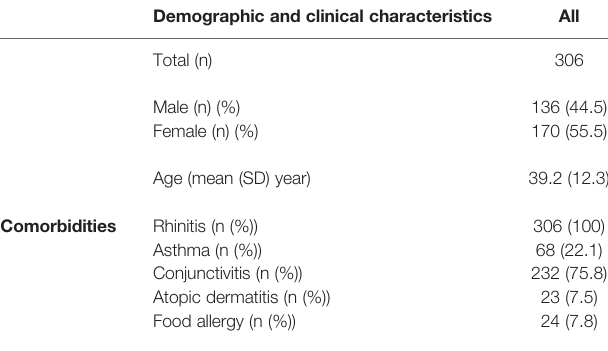
TABLE 1 | Characteristics of the stage I discovery